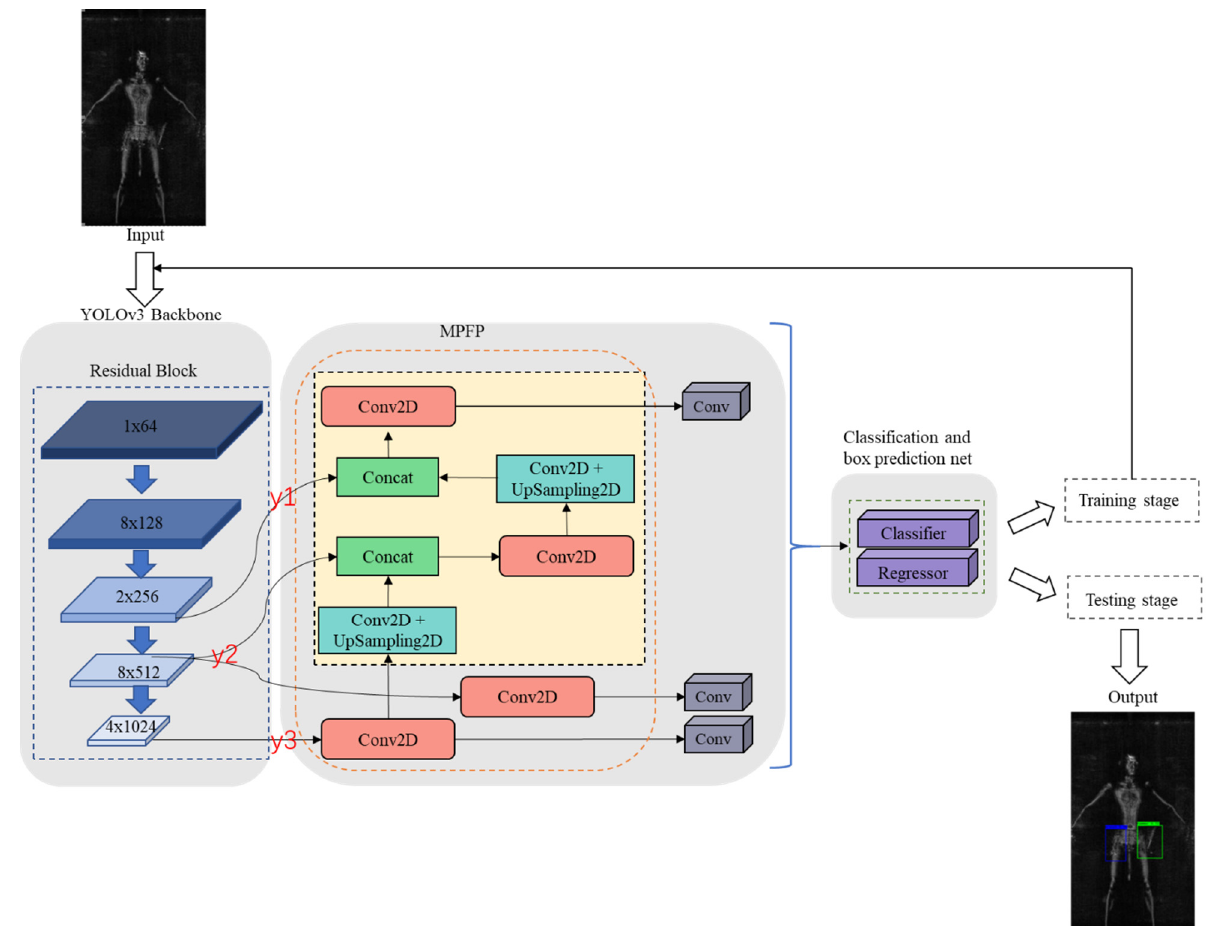
Figure 5. Network structure diagram.